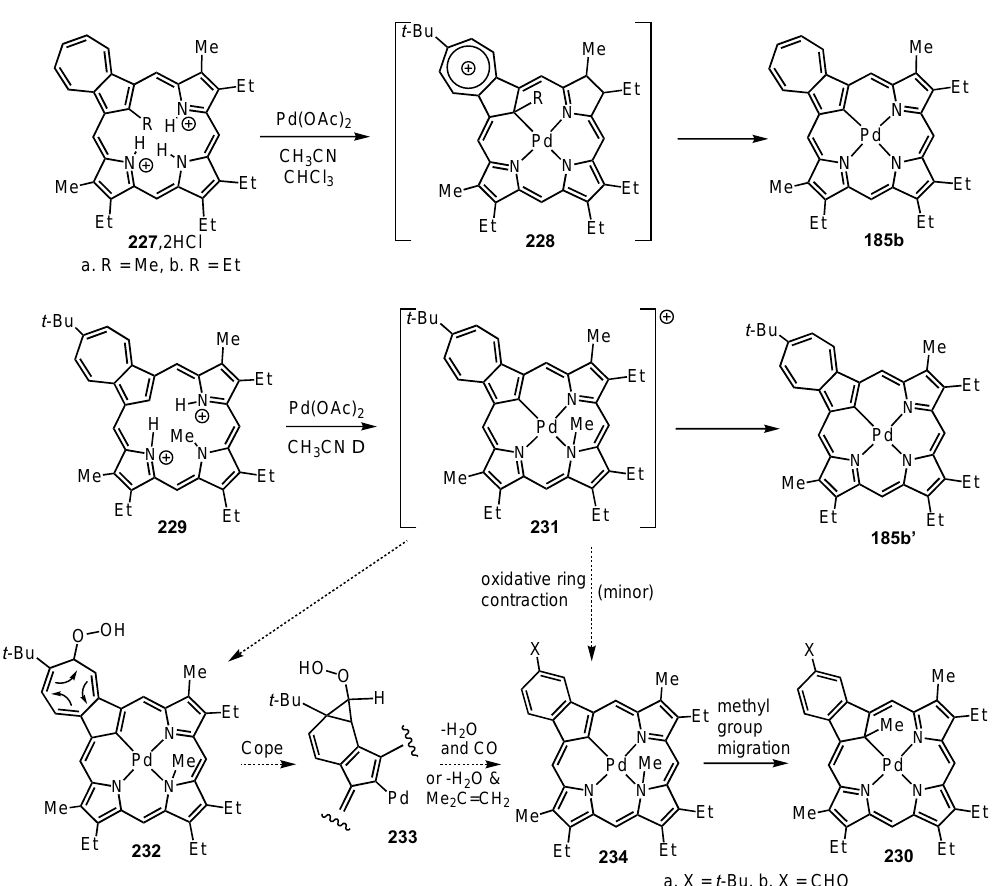
Scheme 37. Palladium complexes derived from internally alkylated azuliporphyrins.